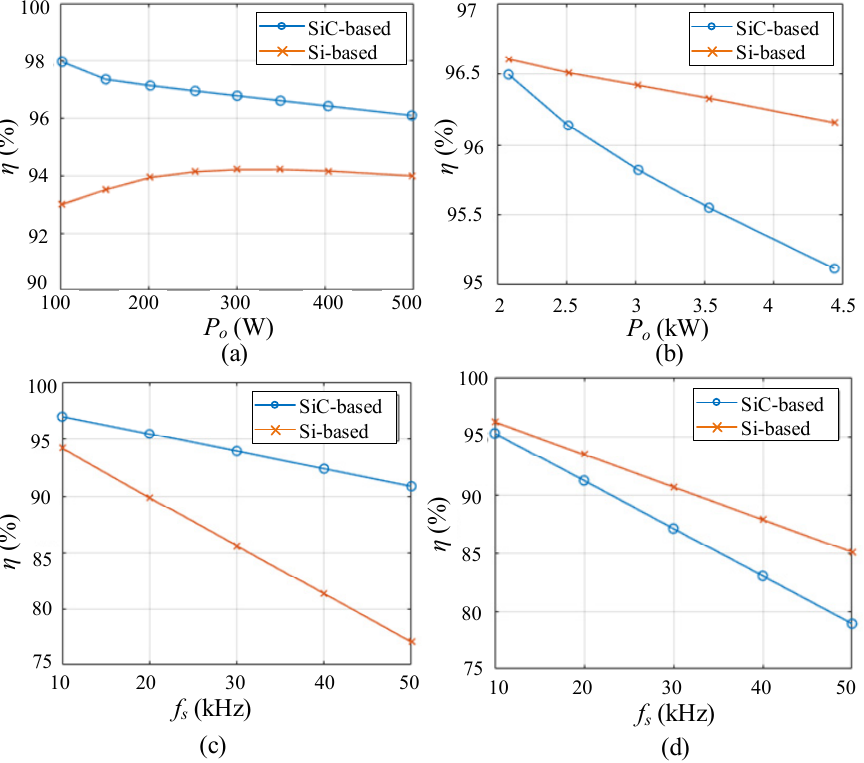
Figure 17. The power efficiency comparison between the SiC- and Si-based CSIs: ( a ) the power efficiency versus the output power (when f s = 10 kHz, U dc = 100 V); ( b ) the power efficiency versus the switching frequency (when R load = 20 Ω , U dc = 100 V); ( c ) the power efficiency versus the output power (when f s = 10 kHz, U dc = 400V); ( d ) the power efficiency versus the switching frequency (when R load = 20 Ω , U dc = 400 V).